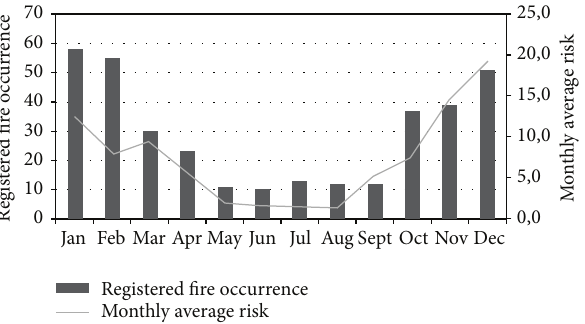
Figure 2: Monthly variation of forest fire risk according to the Telicyn Logarithmic Index and forest fires occurrences registered on eucalyptus plantation of Bahia Specialty Cellulose.